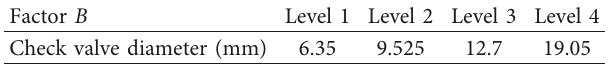
Table 1: Hydraulic cylinder specification. Table 2: Check valves specification.